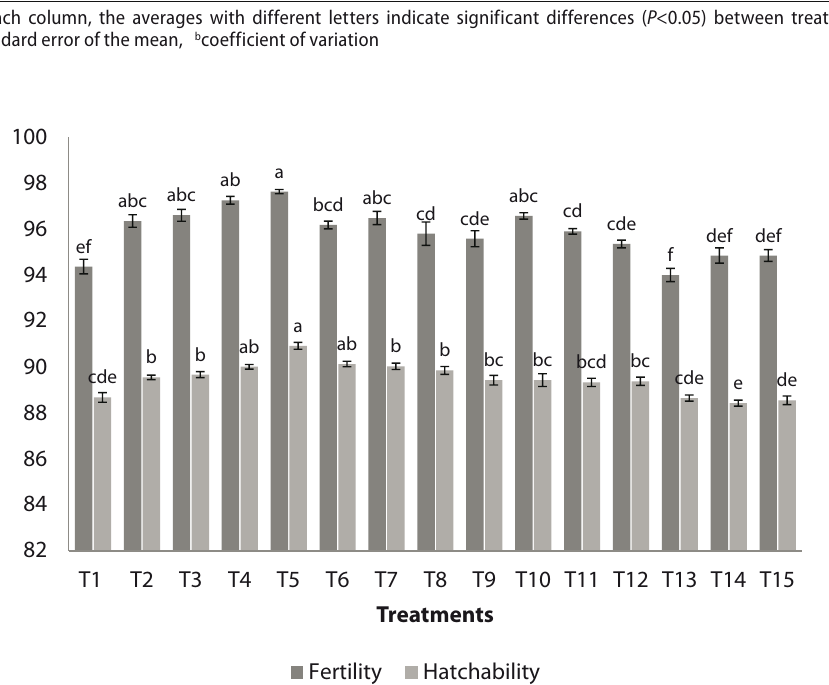
In each column, the averages with different letters indicate significant differences ( P< 0.05) between treatments. a standard error of the mean, b coefficient of variation